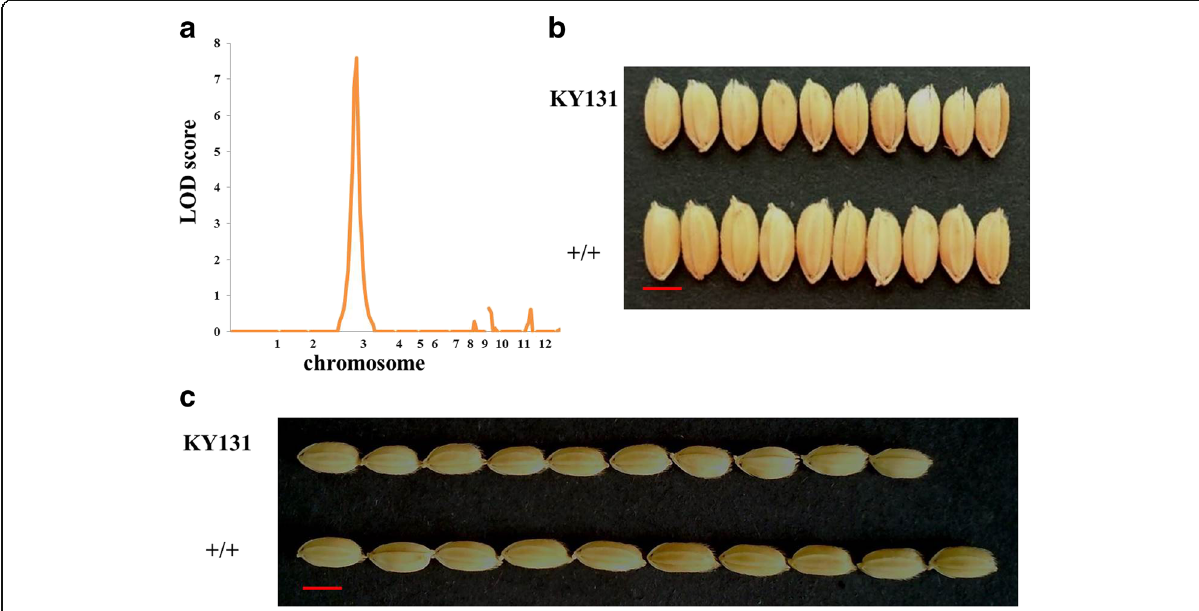
Fig. 5 QTL analysis confirmed that gs3 allele from donor GKBR increased grain length significantly. a QTL analysis using BC 3 F 2 population with 46 lines and 138 SNP markers. b, c the grain length is significantly increased with the donor GKBR allele at GS3 locus. Scale bar, 5 mm. KY131 is the abbreviation of Kongyu